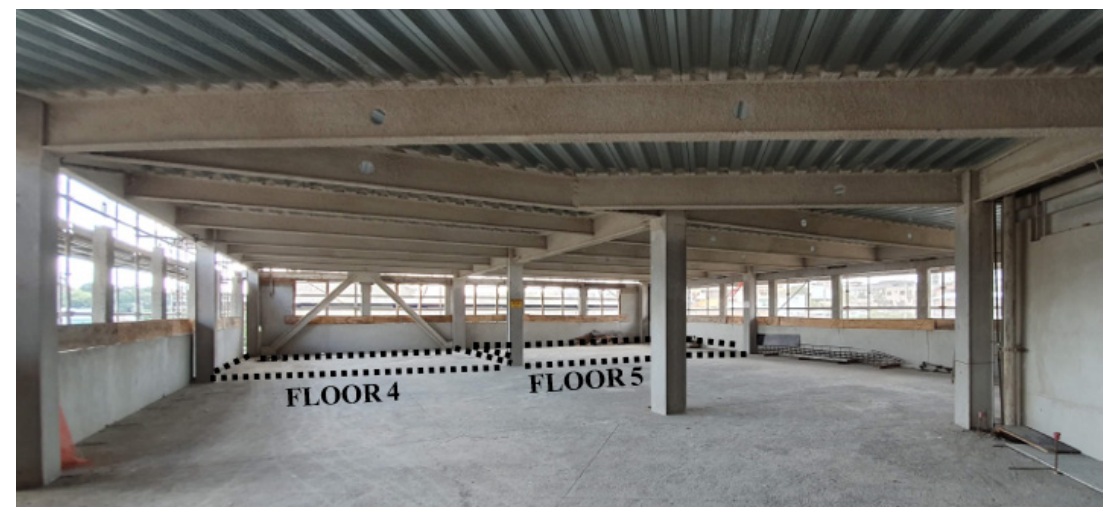
Figure 3. Identification of floors 4 e 5 (Side